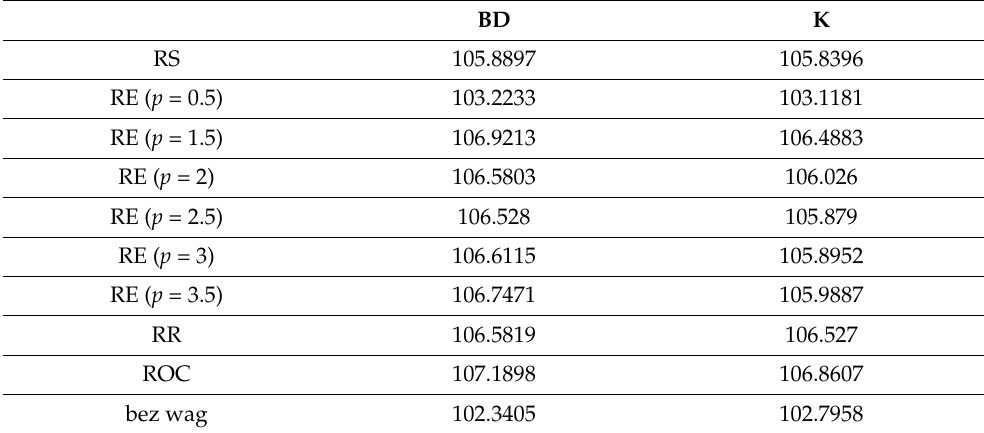
Figure 3. The range of indicator values (left axis) and consistency of results (right axis) for 𝐾𝑃𝐼 𝑡,𝑡 “Consistent KPIs”—KPIs showing the same direction of change compared to the previous year. Table 6. Economic KPI medians ( KPI E ) determined by methods K and t , t 0